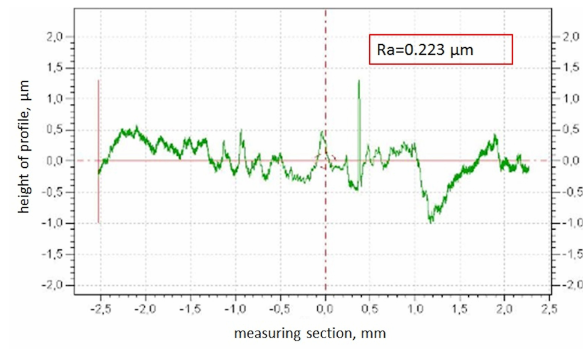
Figure 14: Profilogram of worn seal variant 2 in equator direction